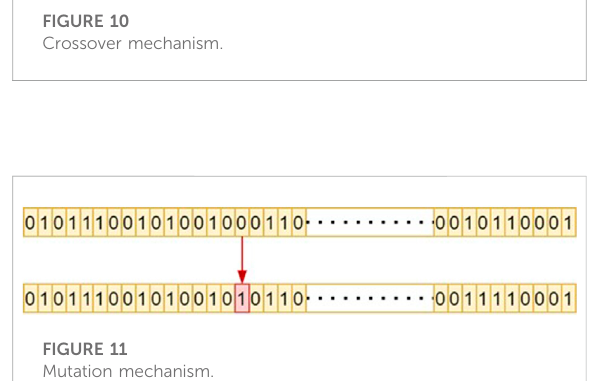
FIGURE 10 Crossover mechanism.